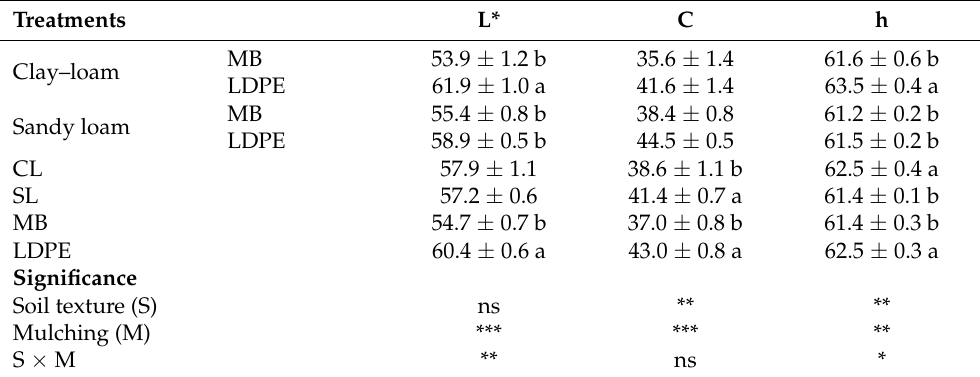
Table 4. Effect of interactions of soil texture (clay–loam—CL; sandy loam—SL) and mulching (biodegradable film—MB; low density polyethylene—LDPE) on color parameters L* (brightness), C (chroma), and h (hue angle) of muskmelon